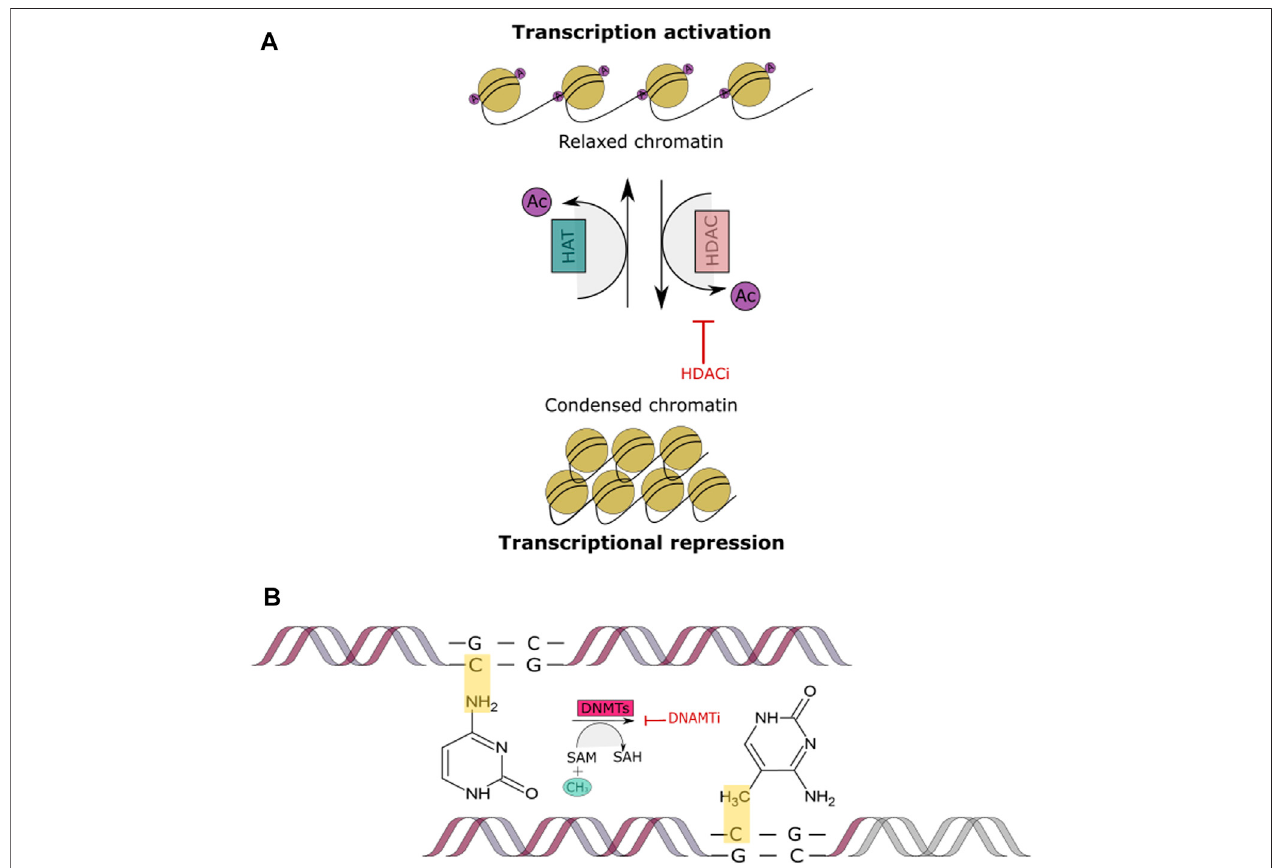
FIGURE 4 | Histone Acetylation and DNA methylation. (A) This fi gure shows the acetylation mechanism of adding an acetyl coenzyme A (acetyl CoA) to the N-terminal tail of a histone through the HAT enzyme, leading to a relaxed chromatin. Conversely, histone deacetylation removes the acetyl CoA through the HDAC enzyme, leading to a condensed chromatin and transcriptional repression. When a HDACi is added the acetyl CoA group cannot be removed and therefore, the chromatinremainsrelaxed andtranscriptionremains active. (B) This fi guredepicts DNAmethylationprocess beingblocked byaDNMTI. Theinhibitor prevents the addition of the methyl group to the CpG island site in DNA, inhibiting transcriptional